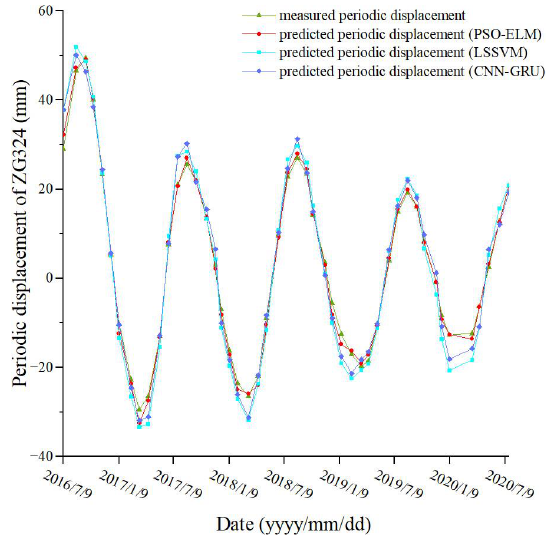
Figure 15. Predicted periodic displacement for different models.